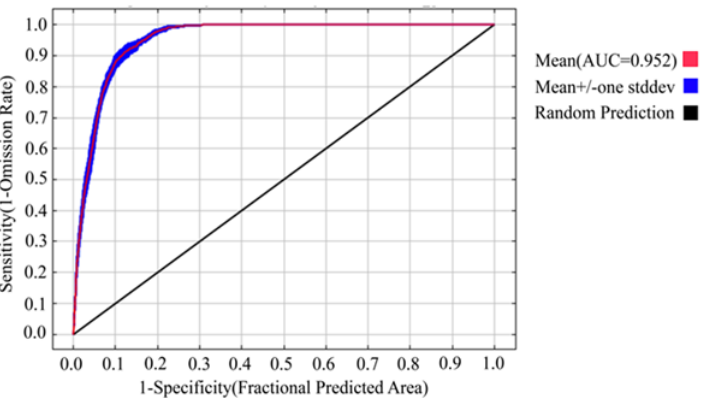
Figure 3. AIC value of the parameter combination (FC, RM) based on ENMeval.